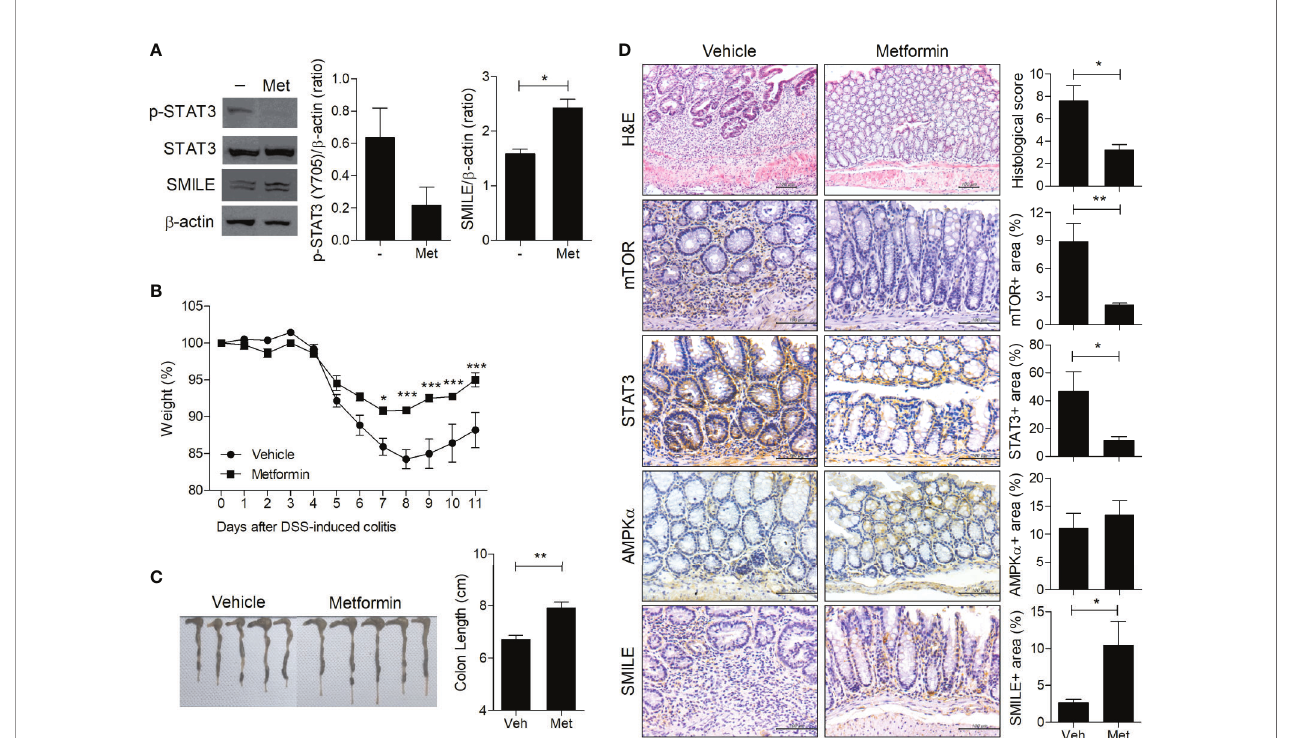
FIGURE 1 | Metformin upregulates SMILE in DSS-induced colitis. (A) Western blots of STAT3, p-STAT3, and SMILE expression in metformin (5 mM)-treated and untreated HT-29 cells for 48 h, followed by densitometric analysis. (B) Metformin (50 mg/kg) was administered with DSS. Body weight is expressed as a percentage (n = 5). (C) Colon length ofmice with DSS-induced colitis on day 11. Macroscopic images of the colon are shown, and the colon length was measured. (D) Hematoxylin and eosin (H&E) staining andIHC with anti-mTOR, -AMPK,and -STAT3 antibodies of colon sectionsfrom the DSS vehicleand metformin groups. The score and positive area were determined. Data are means±SEM ofthree replicates. * P < 0.05, ** P < 0.01, *** P <